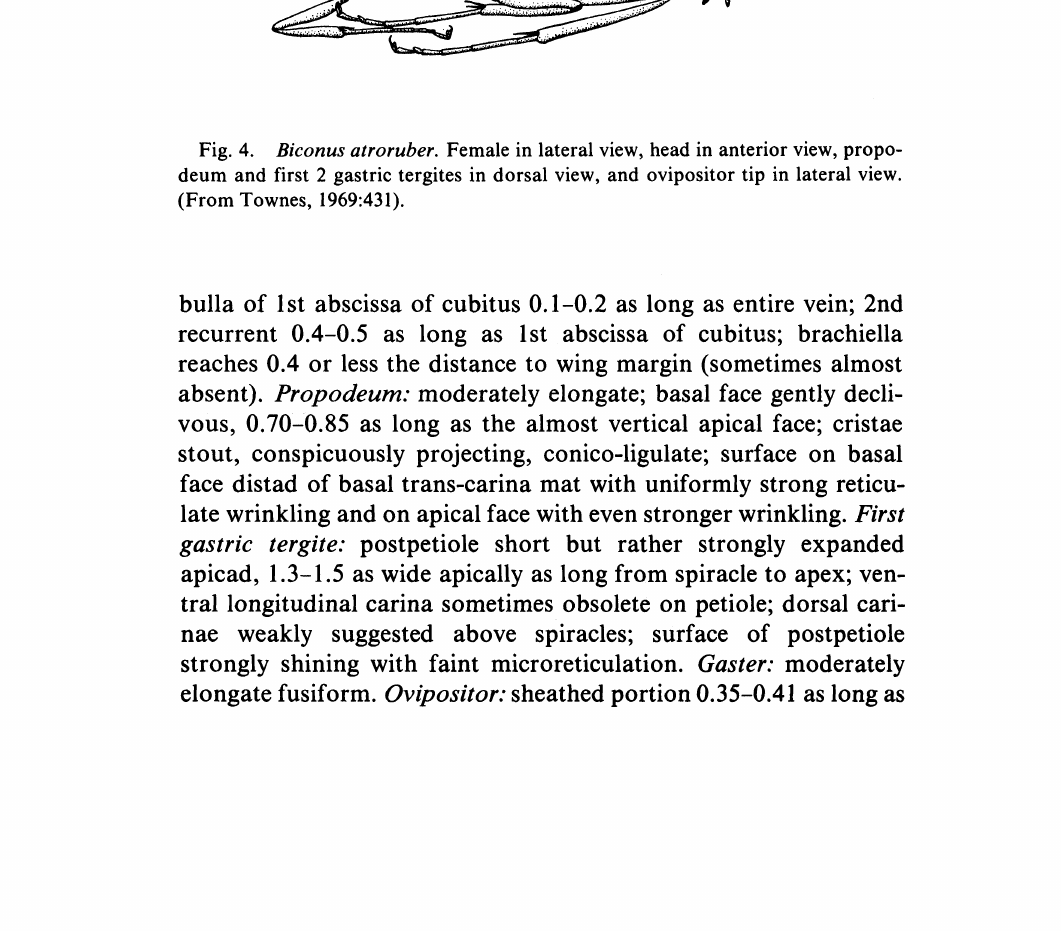
Fig. 4. Biconus atroruber. Female in lateral view, head in anterior view, propo- deum and first 2 gastric tergites in dorsal view, and ovipositor tip in lateral view. (From Townes,